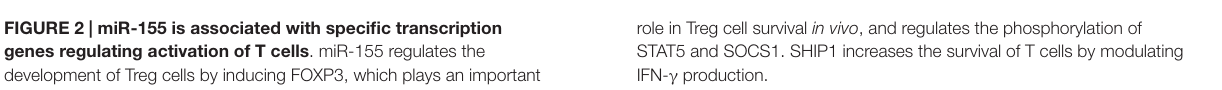
FIGURE 2 | miR-155 is associated with specific transcription genes regulating activation of T cells . miR-155 regulates the development of Treg cells by inducing FOXP3, which plays an important